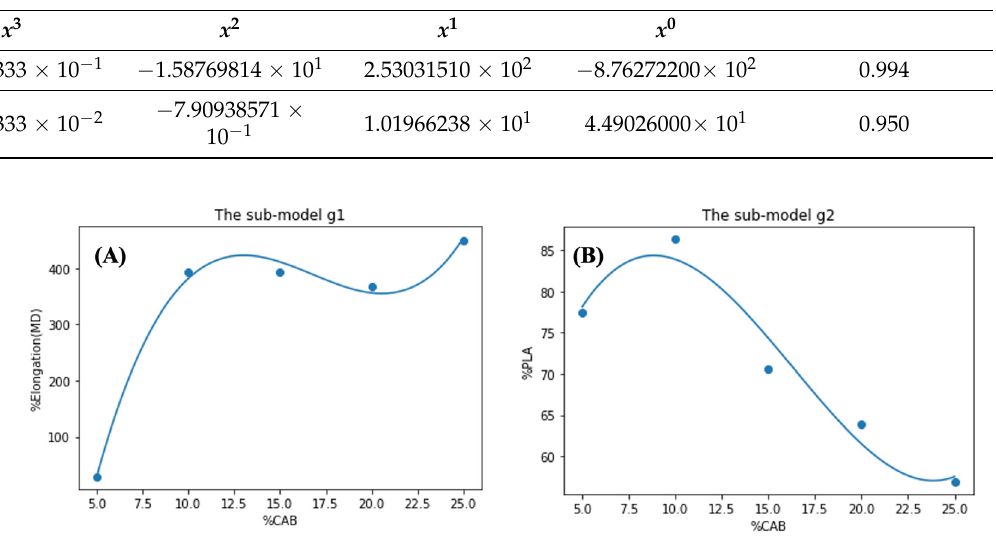
Figure 11. The local models at each %CAB with the maximum value highlighted (orange dots). For the second step, “ the global model ” was computed using the maximum value and its corresponding minimizer from the data in Table 3. The global model consists of 2 sub- models, g 1 : %CAB → %Elongation and g 2 : %CAB → %PLA where 5 ≤ %CAB ≤ 25. In the same manner as the first step, both two sub-models were fitted with a three-degree polynomial functions, as shown in Table 4, and plotted in Figure 12A,B, respectively. Table 4. The two sub-models of the global model. Global Model